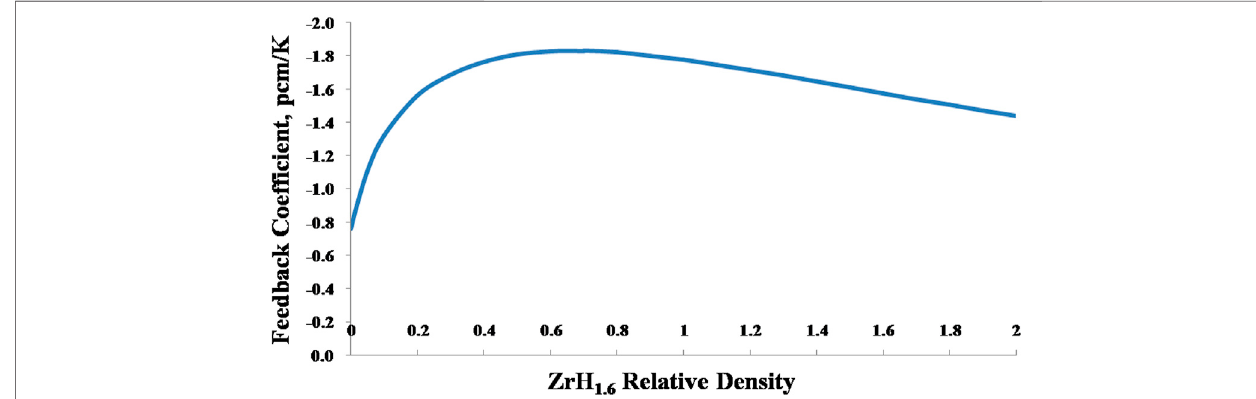
FIGURE 5 | Fuel temperature feedback coef fi cient versus ZrH 1.6 relative density.